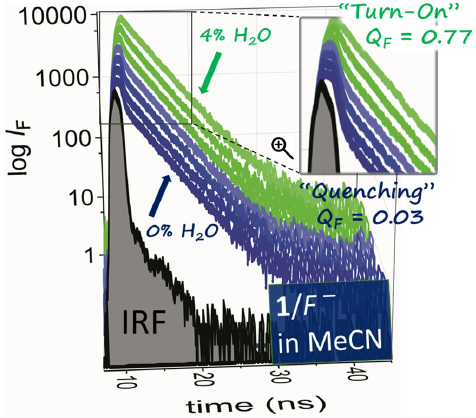
Figure 2. Evolution of the fluorescence lifetime of two-component coumarin oxime 1 / F − sensor in MeCN during its titration with water (5 × 10 − 5 mol L − 1 1 + 1 × 10 − 2 mol L − 1 TBA + F − ;